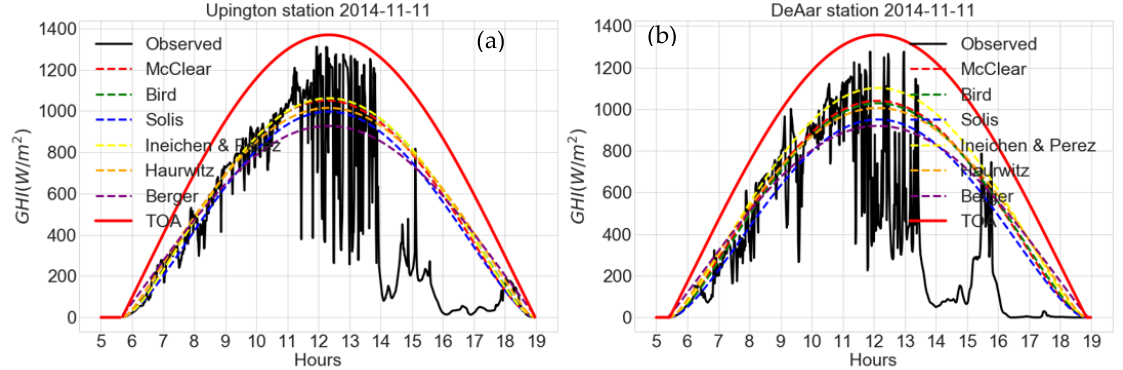
Figure 3. A plot of observed radiation data on 11 November 2014 at Upington station ( a ), and De Aar station ( b ), 6 clear models and extra-terrestrial radiation on a horizontal surface on what ERA5 data classified as a cloudy day.